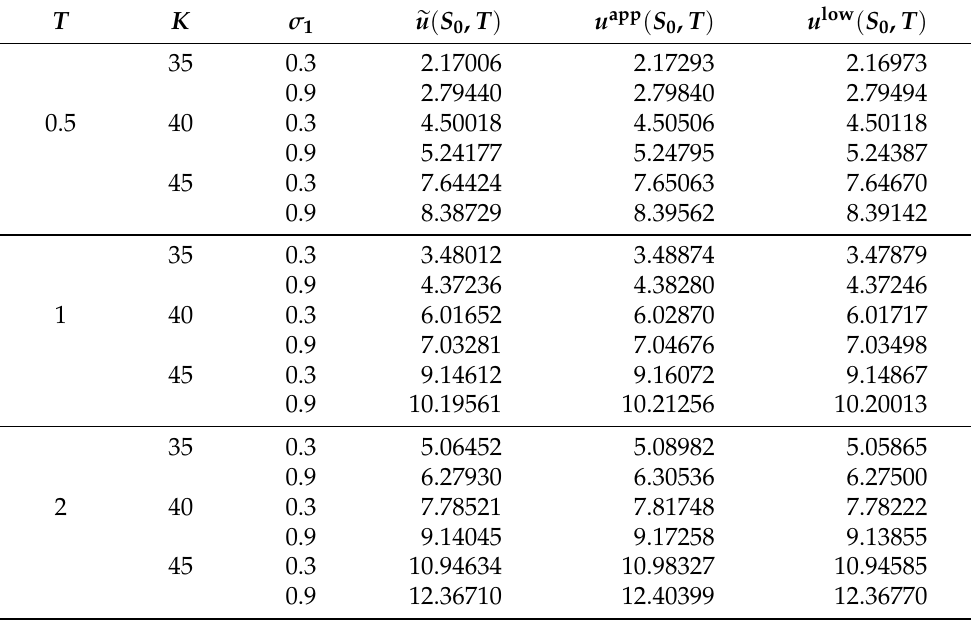
Table 4. Reference values r u p S 0 , T q , u app p S 0 , T q , u low p S 0 , T q for American basket put